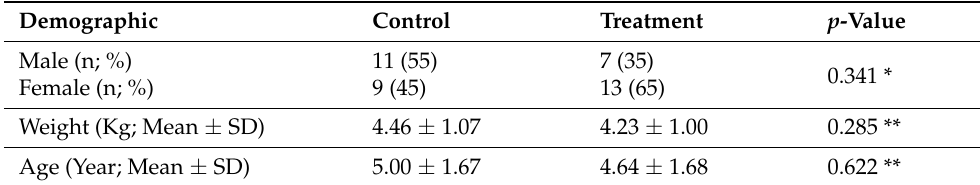
Table 1. Demographic data of the experimental cats. Demographic Control Treatment p -Value Male (n;